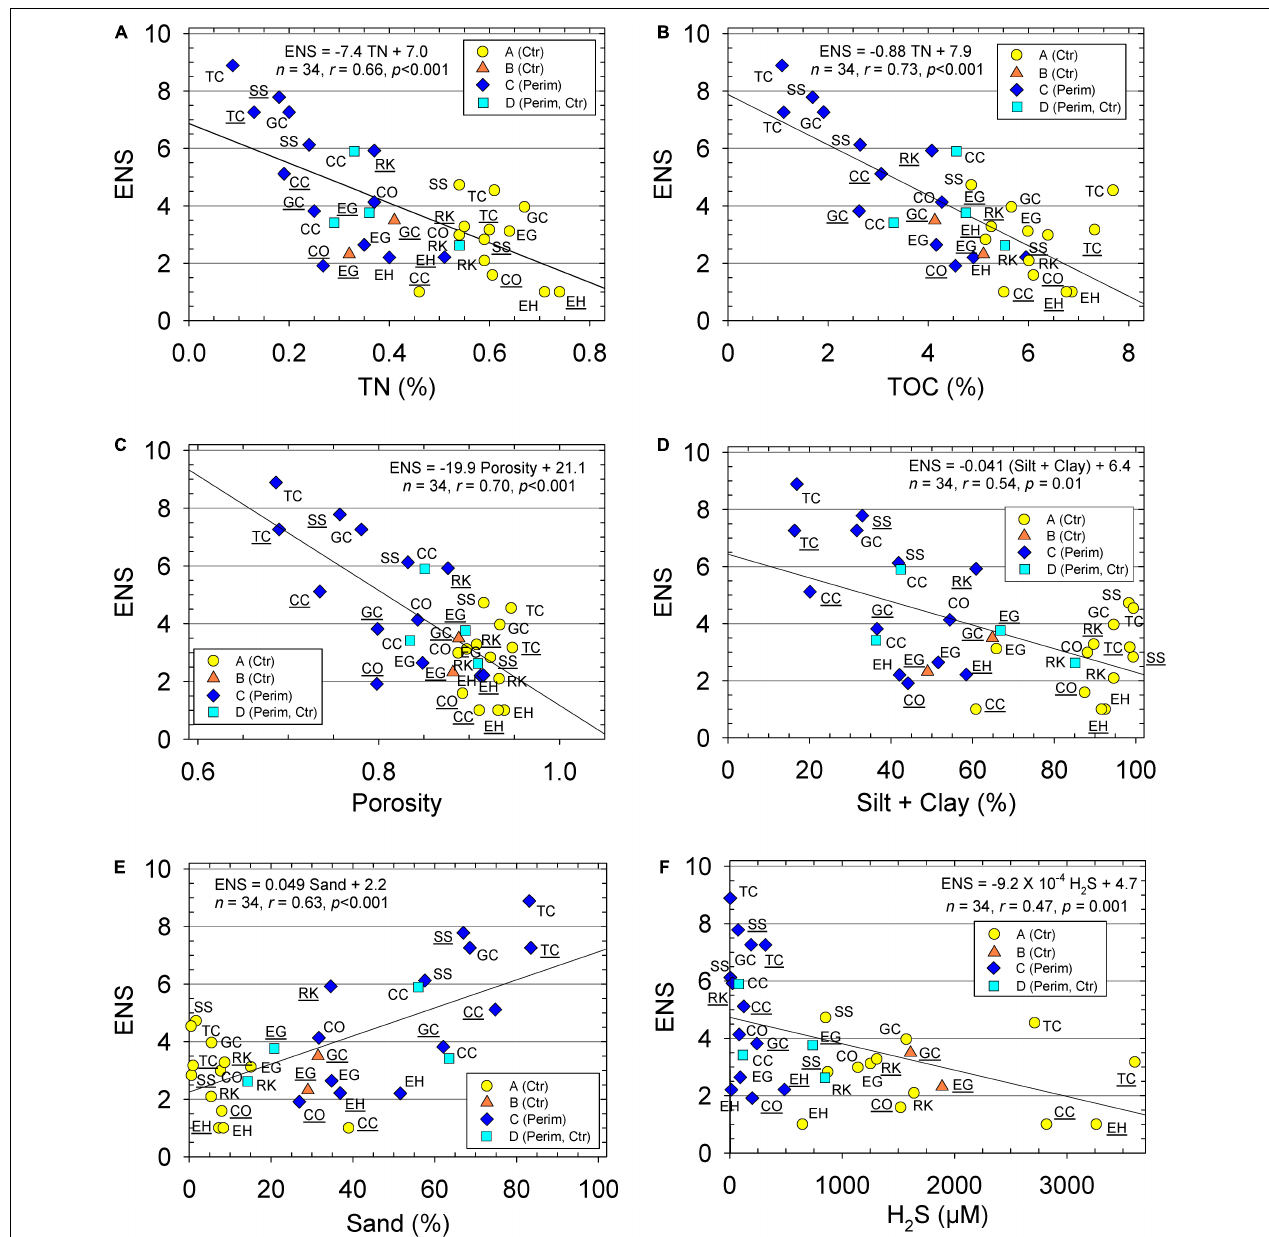
FIGURE 4 | Effective number of species (ENS) vs. (A) sediment total nitrogen (TN), (B) sediment total organic carbon (TOC), (C) porosity, (D) silt + clay, (E) sand, and (F) porewater hydrogen sulfide (H 2 S). Data for perimeter (Perim) and center (Ctr) deposits of muddy sediment. Equations and lines from linear regression, correlation coefficient ( r ), number of samples ( n ), and p statistic. Stations with ID underlined were sampled during wet season and with no underline for dry season. Groups determined from hierarchical cluster analysis are identified with different